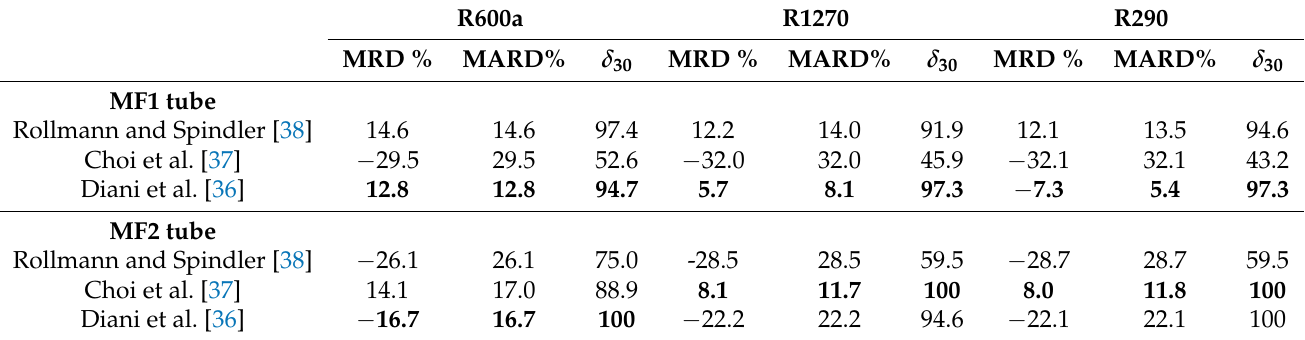
Table 5. Comparison between experimental data and correlations for prediction of pressure drop in microfinned tubes, with best performing correlations highlighted in